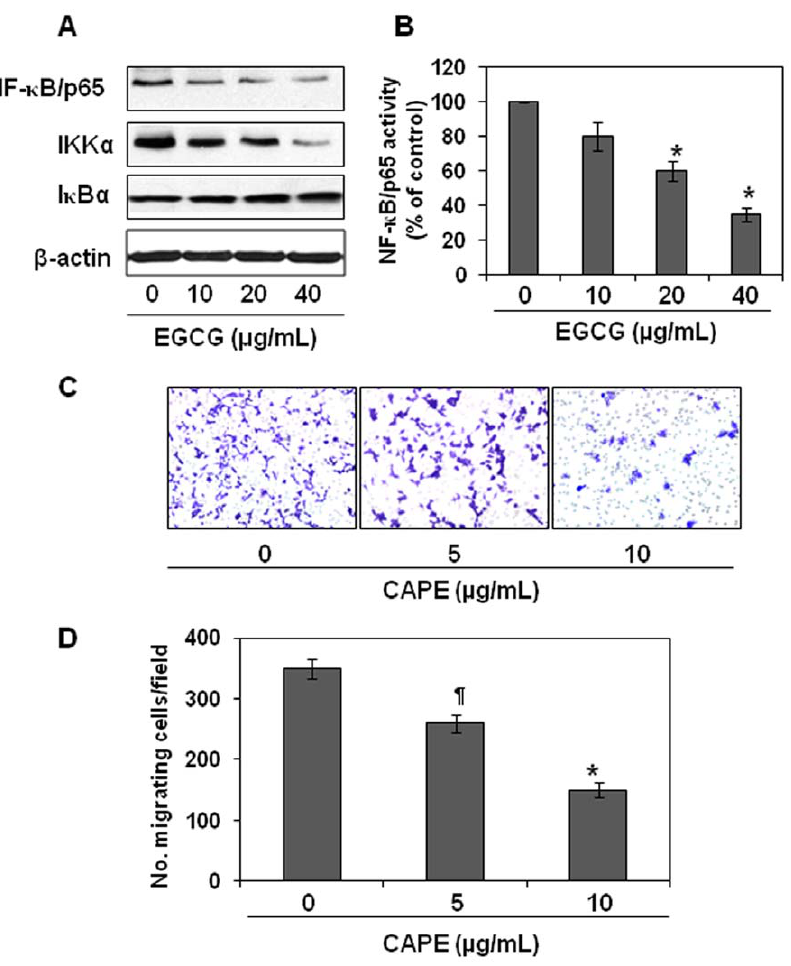
Figure 6. Effect of EGCG on NF- k B activation in melanoma cells. ( A ) Treatment of A375 cells with EGCG decreases the basal level of NF- k B/ p65 and IKK a while inhibiting the degradation of I k B a . After 24 h treatment with various concentrations of EGCG the cells were harvested and cytosolic and nuclear fractions were prepared and subjected to the analysis of NF- k B, IKK a and I k B a using western blot analysis. Representative blot is shown from three independent experiments with identical observations. ( B ) The activity of NF- k B/p65 in the nuclear fraction of the cells after treatment with and without EGCG for 24 h was measured using NF- k B/p65-specific activity assay kit, n=3. Activity of NF- k B is expressed in terms of percent of control (non-EGCG-treated) group. Significant decrease versus control: * P , 0.001. ( C ) Treatment of A375 cells with caffeic acid phenethyl ester (CAPE), an inhibitor of NF- k B, inhibits melanoma cell migration. Representative photomicrographs are shown from three separate experiments. ( D ) Data on cell migration capacity are summarized as the mean number of migratory cells 6 SD/microscopic field, n=3. Significant inhibition versus non-CAPE-treated cells: " P , 0.05; * P , 0.001.